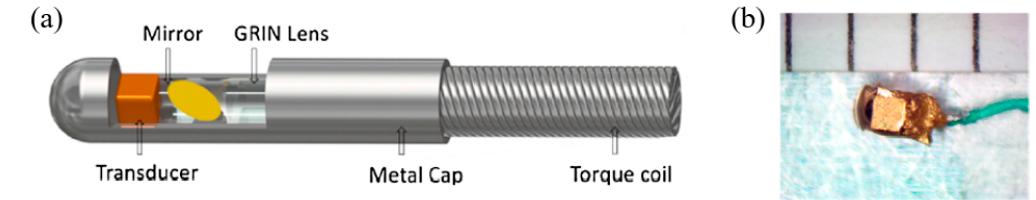
Figure 12. ( a ) Schematic of the imaging probe. ( b ) Photograph of the fabricated pMUT (Reproduced with permission from Elsevier [72]).